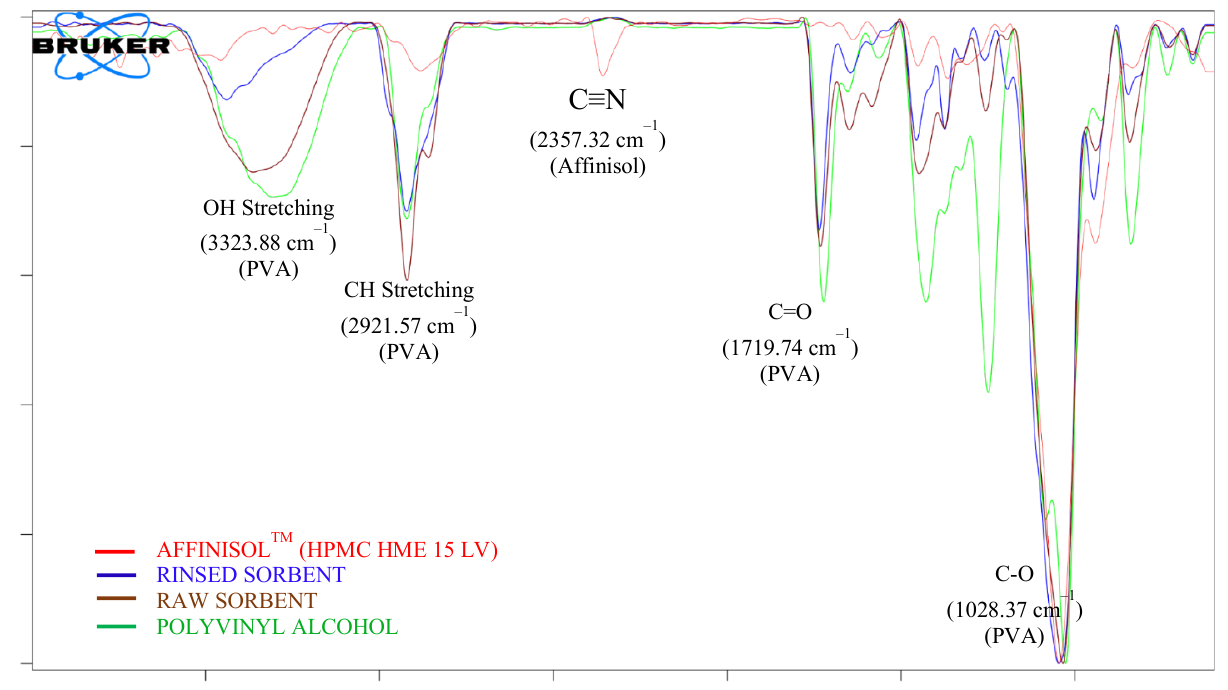
Figure 4. Over laid ATR-FTIR spectra of Affinisol TM (HPMC HME 15 LV), rinsed sorbent, raw sorbent and Figure 4. Overlaid ATR-FTIR spectra of Affinisol™ (HPMC HME 15 LV), rinsed sorbent, raw sorbent polyvinyl alcohol. and polyvinyl